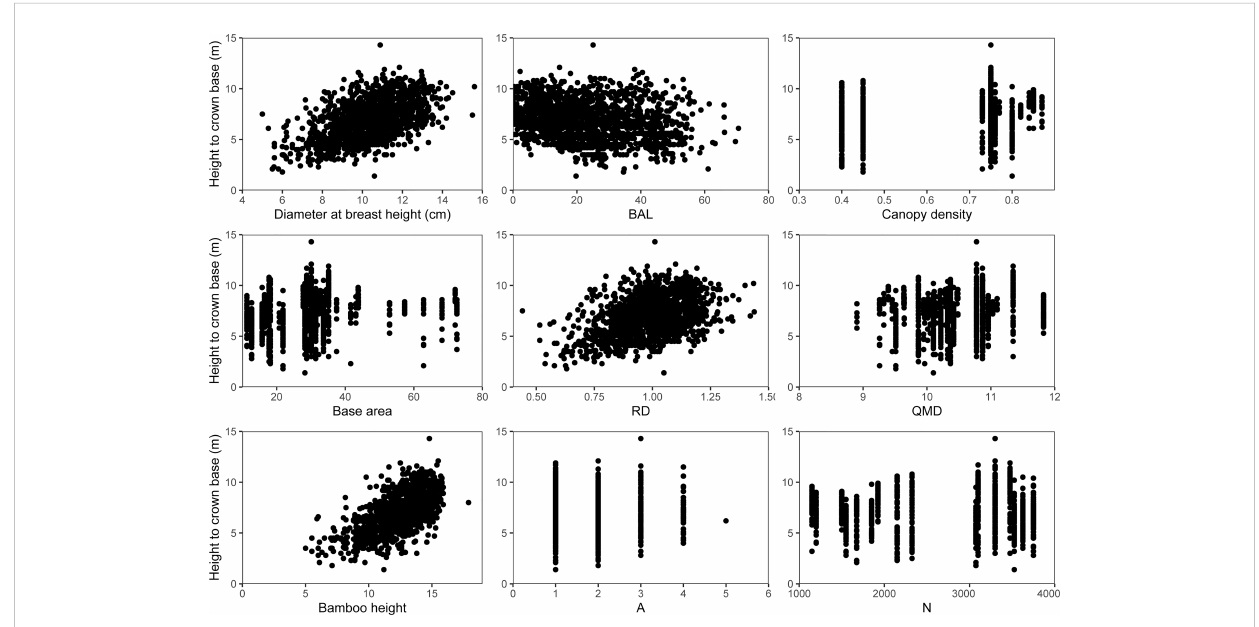
FIGURE 3 Scatter plots of HCB versus different predictor variables evaluated for their potential contribution to the HCB model of moso bamboo.